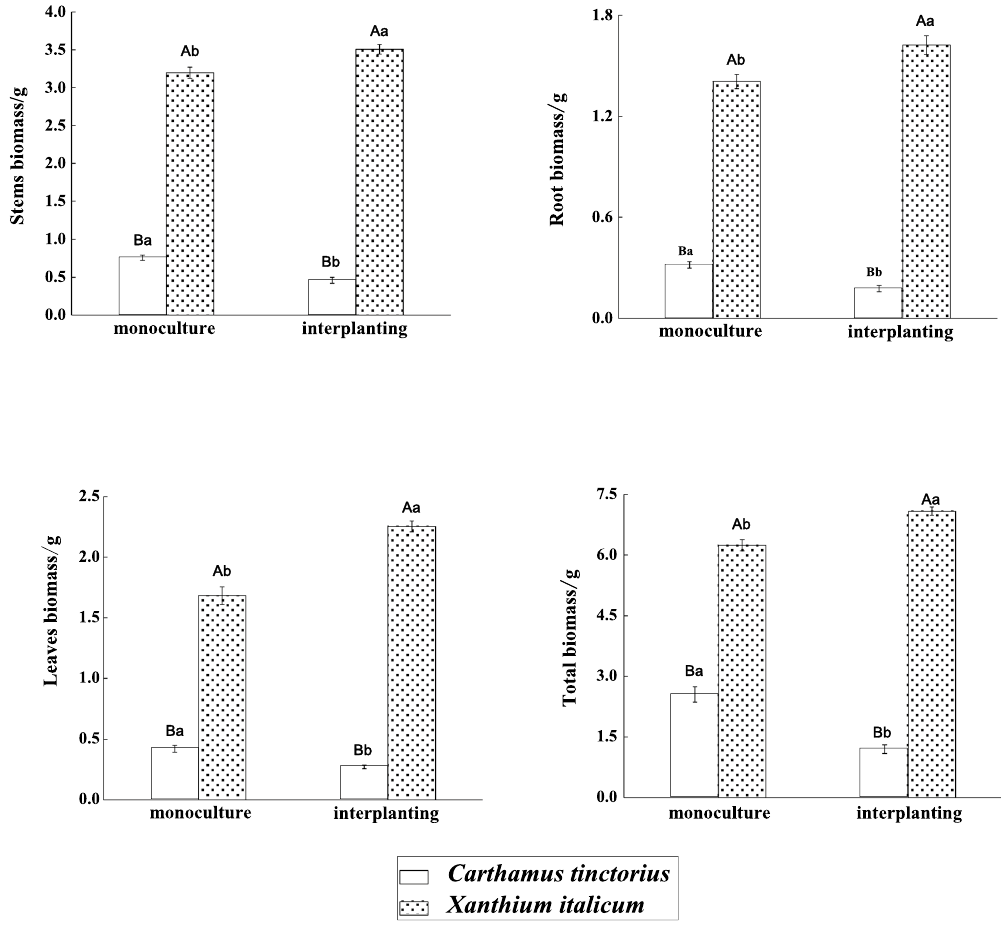
Figure 2. The biomass of X. italicum and Carthamus